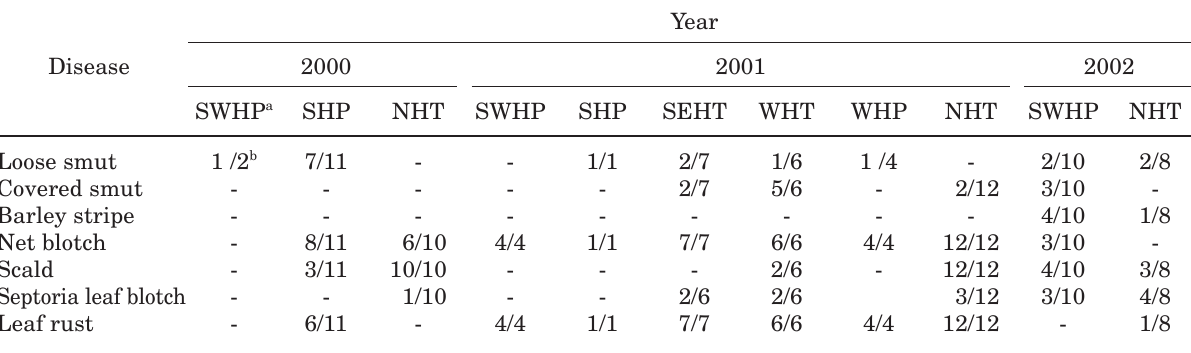
a For abbreviations see Table 1. b Fields with disease/Total fields surveyed.